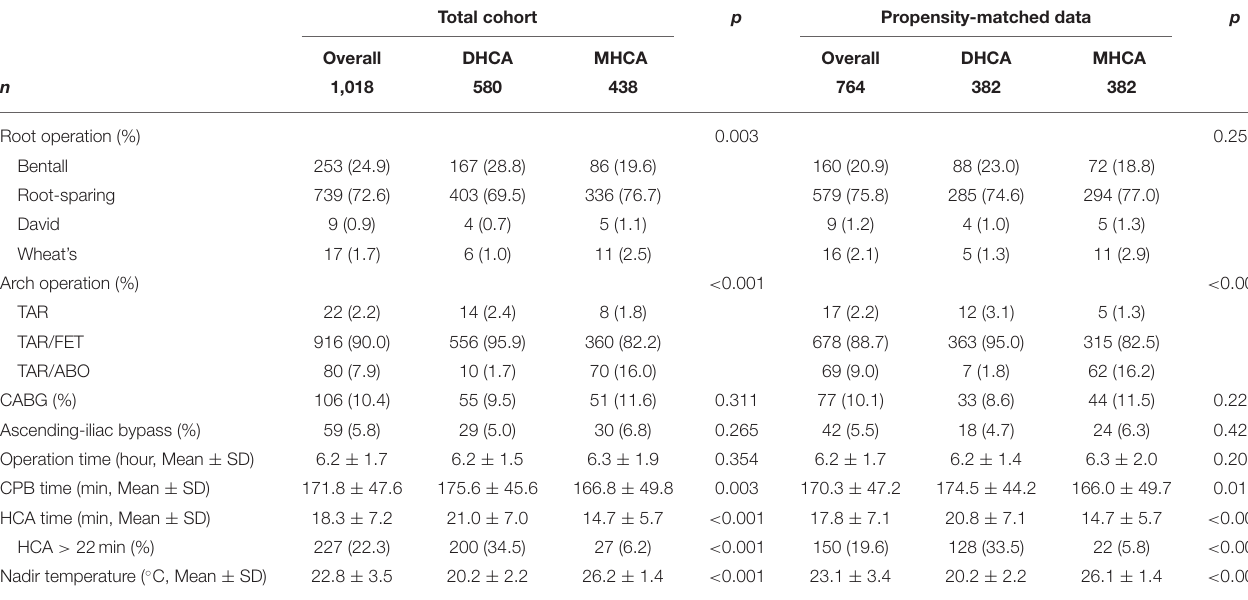
TABLE 2 | Operative data.